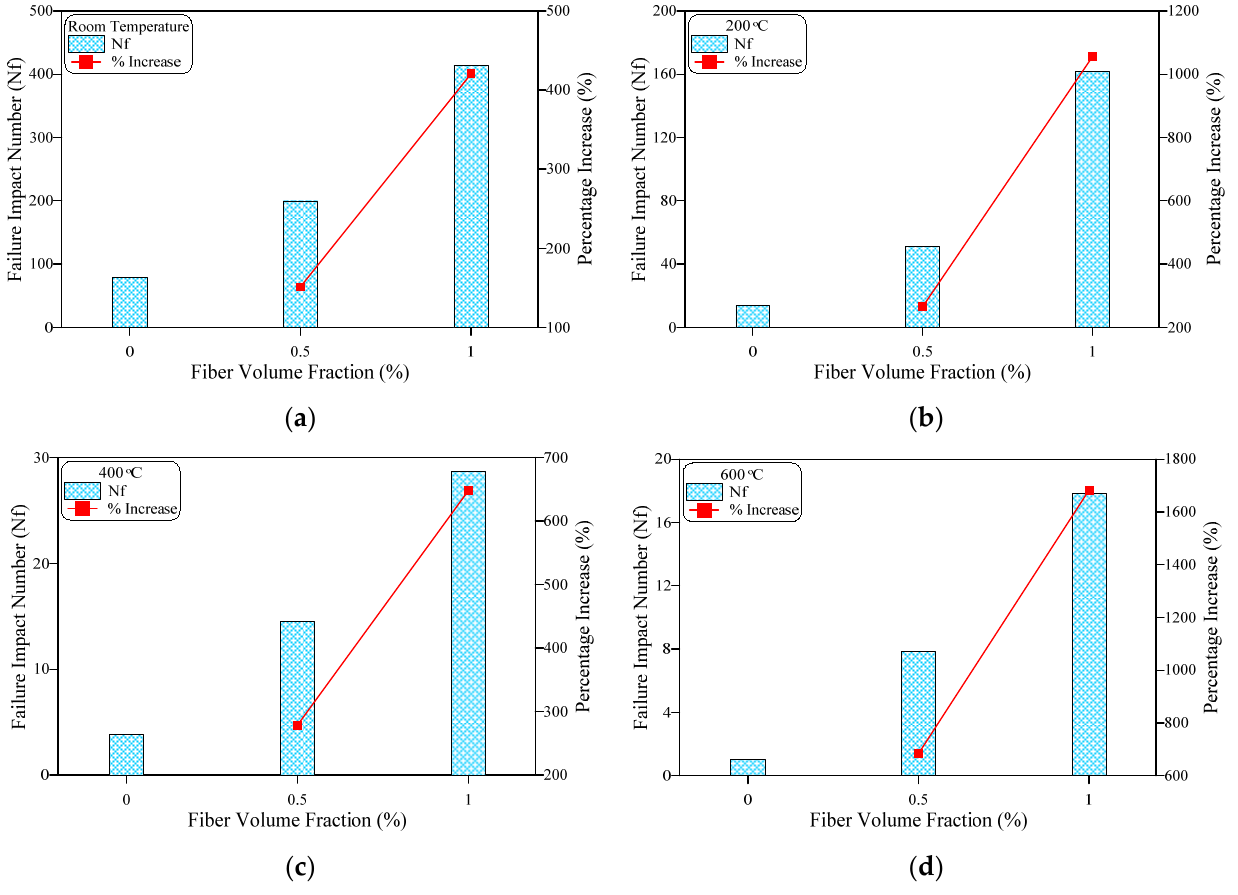
Figure 11. Failure impact number results of disc specimens. ( a ) Room temperature; ( b ) 200 °C; ( c ) 400 °C; ( d ) 600 °C.